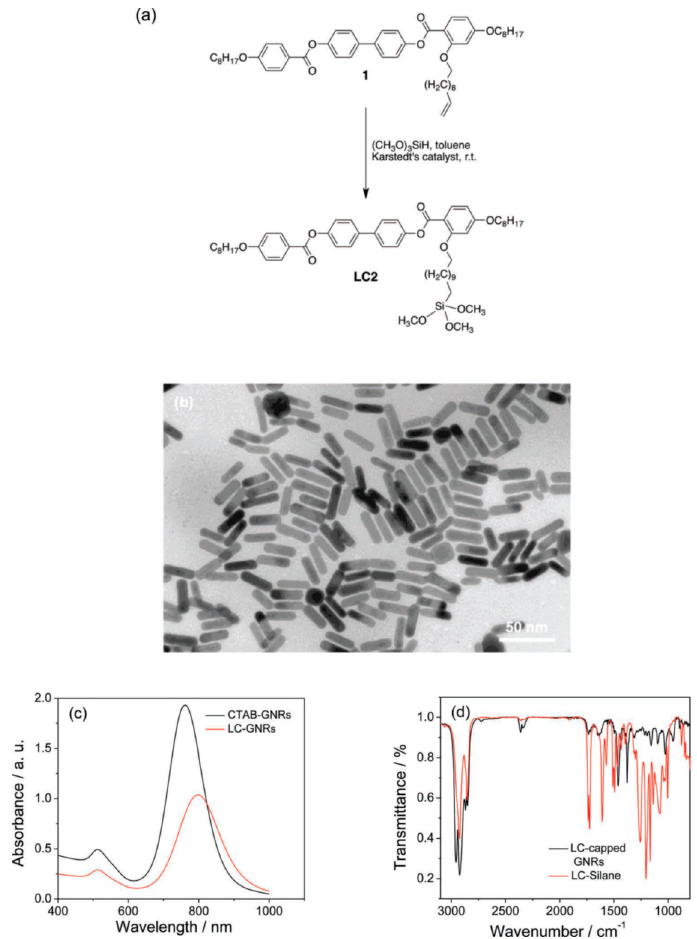
Figure 5. ( a ) Synthesis of the LC silane LC2. ( b ) TEM image obtained for CTAB-stabilized gold nanorods (GNRs) in water. ( c ) UV-visible-NIR spectra recorded for CTAB-capped GNRs. ( d ) Overlapping IR spectra of the capped GNRs and LC silane. Reproduced with permission from Ref. [80] (WILEY-VCH Verlag GmbH and Co. KGaA, Weinheim,